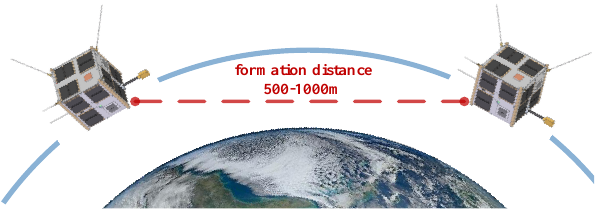
Figure 6. Schematic diagram of the CanX-4/CanX-5 formation flight.